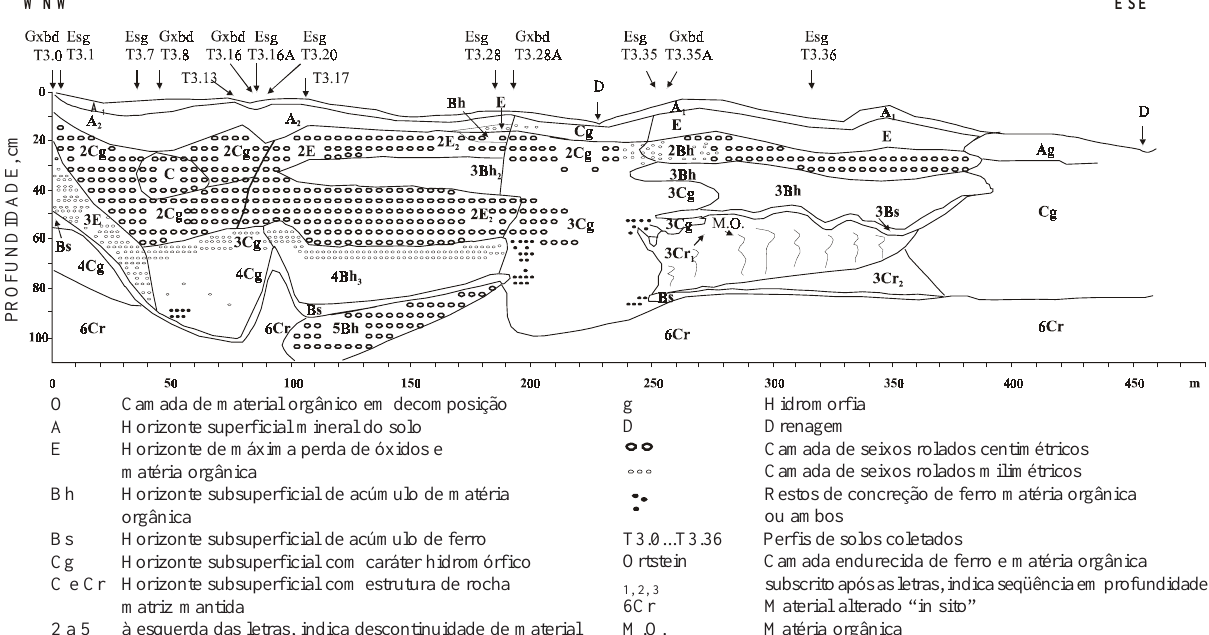
Figura 3. Representação reduzida da toposseqüência mostrando os Espodossolos (ESg) e Gleissolos (GXbd) da área de estudos. Na figura 4, estão representados em detalhe os perfis T3.28 e 28A, e T3.35 e